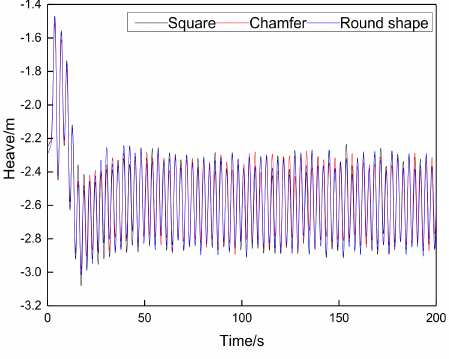
Figure 7. The trajectory of the device in the heave direction.